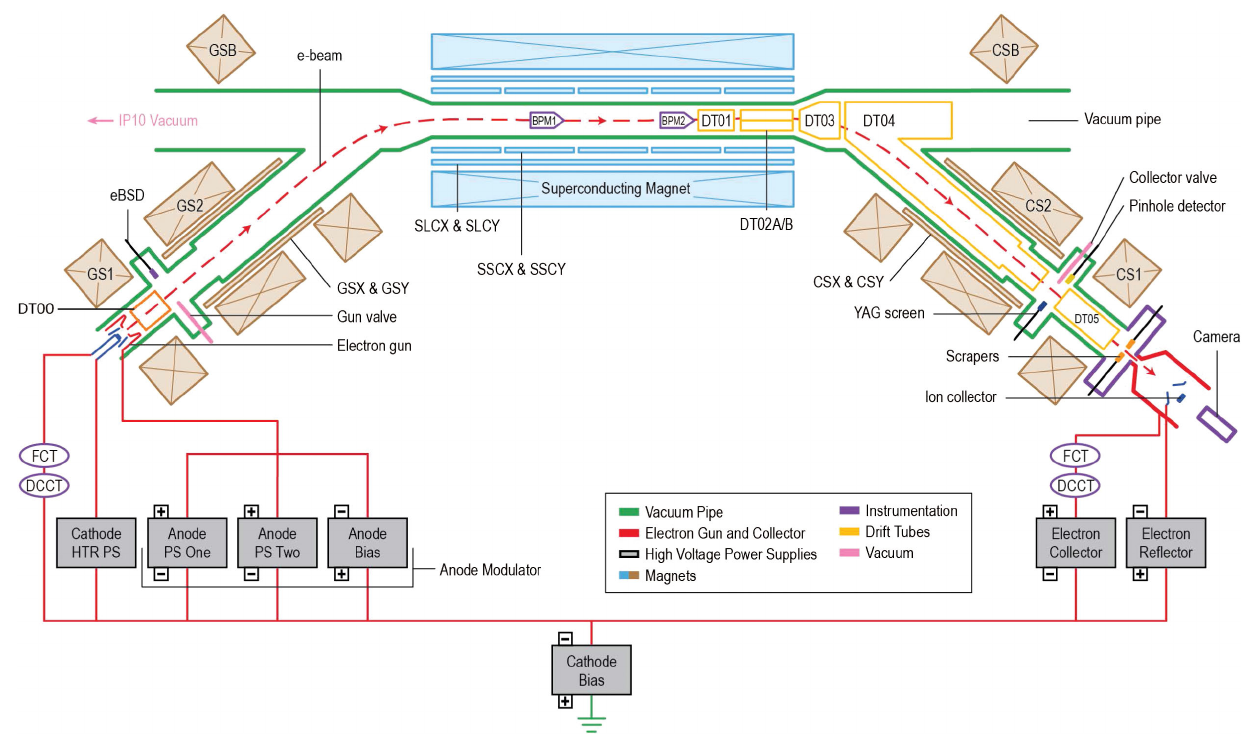
FIG. 3. Schematic layout of the RHIC electron